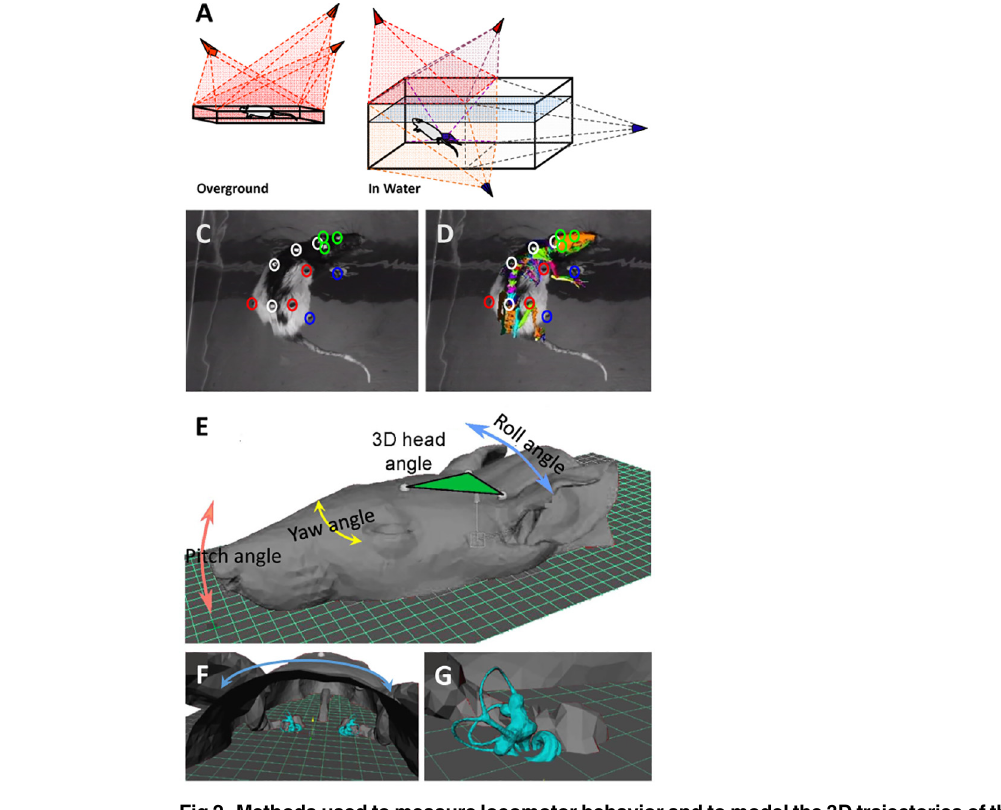
Fig 2. Methods used to measure locomotor behavior and to model the 3D trajectories of the different part of the skeleton. (A) Setup used on overground; 3 cameras permit motion capture of the rat on the ground. (B) Setup used to capture motion of the rat in the water; 2 cameras capture the movement of the rat over the water, and 3 cameras capture the movement underwater. (C) Position of the different markers on the skin of the rat. Green for the head, white for the vertebral column, red for the girdles and blue for the distal part of the limbs. (D) The cutaneous markers and their relative positions on the skull. (E) Head of the rat and the different angles analyzed (3D angle, Pitch H , Yaw H and Roll H ). (F) Occipital view of the head and localization of the three semicircular canals. (G) Focus on the vestibular